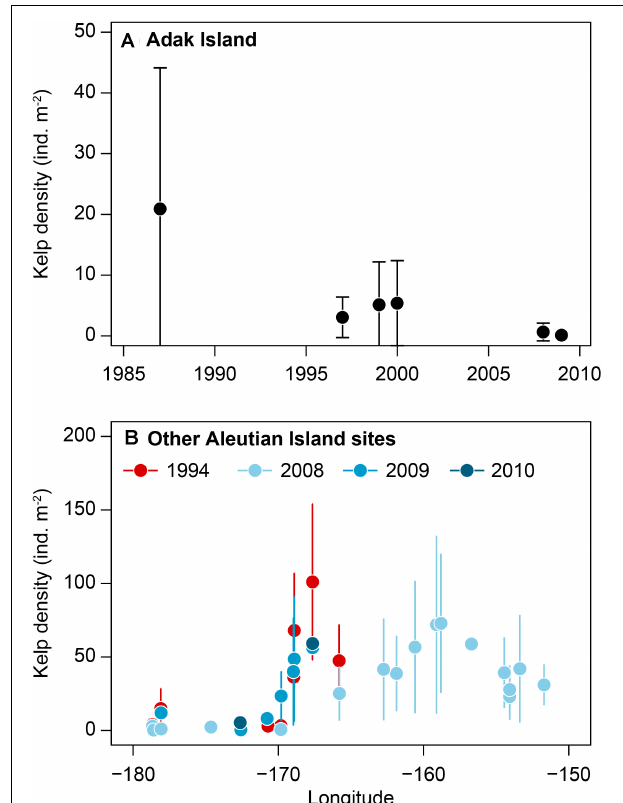
FIGURE 2 | Time series of kelp density (Mean ± SD) in Aleutian Islands, Alaska: (A) Adak Island 1987–2009 (the most data-rich site, –176.6 ◦ W), (B) various sites in Aleutian Islands in 1994 and late 2000s. Data sourced from NCEAS dataset (Krumhansl et al.,